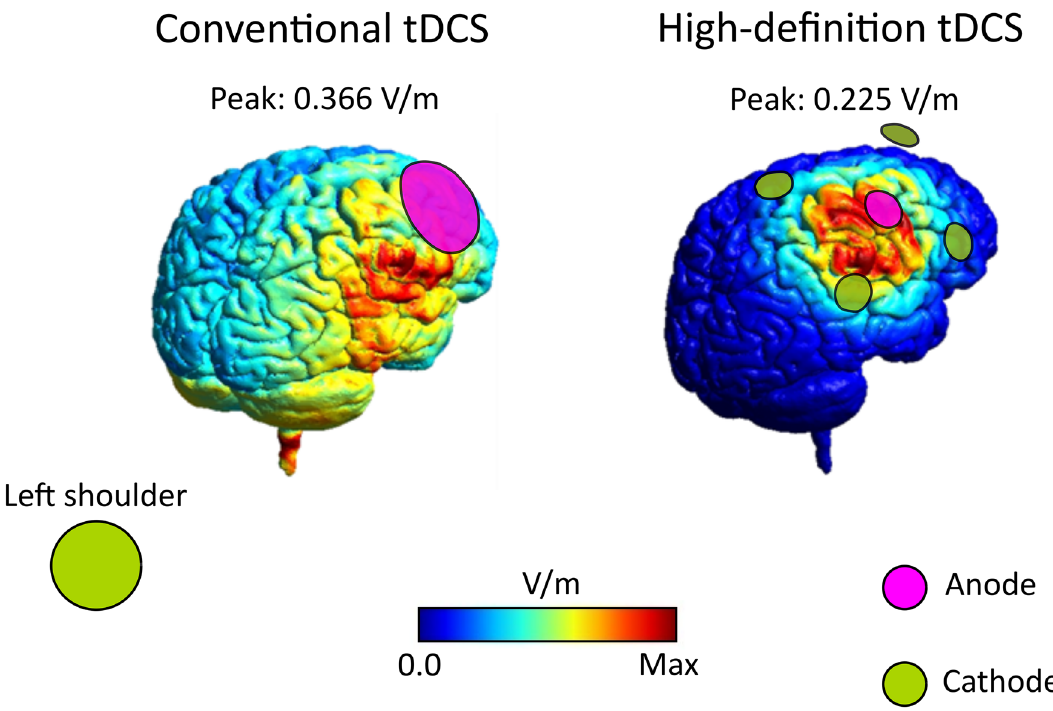
Figure 2. Conventional vs. HD-tDCS simulations. Finite element method (FEM) simulations showing the electric fields of Conventional and HD-tDCS montages, both estimated by SimNIBS 65 . In the image on the left, the electric field of Conventional tDCS (anode: C4; cathode: left shoulder). On the right, the electric field of HD-tDCS (anode: C4; cathodes: FC2, FC6, CP2, CP6). As shown, the electric field elicited by HD-tDCS is much more focal than Conventional tDCS where the current is more